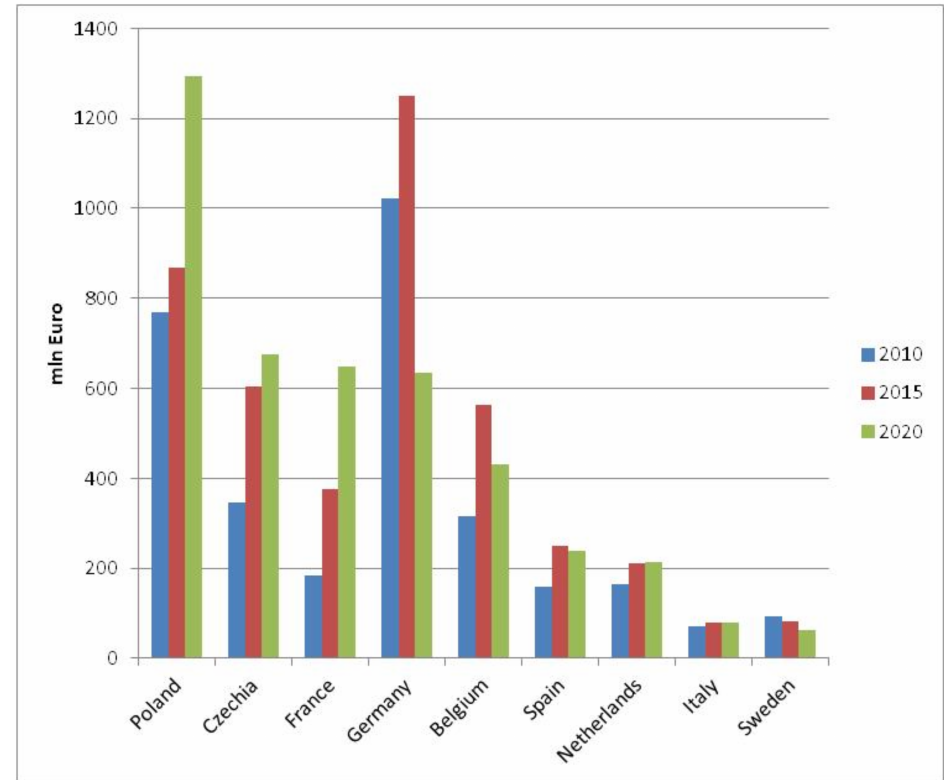
Figure 1. Exports of buses from main producing countries in the EU. Source of data: Eurostat COMEXT database.